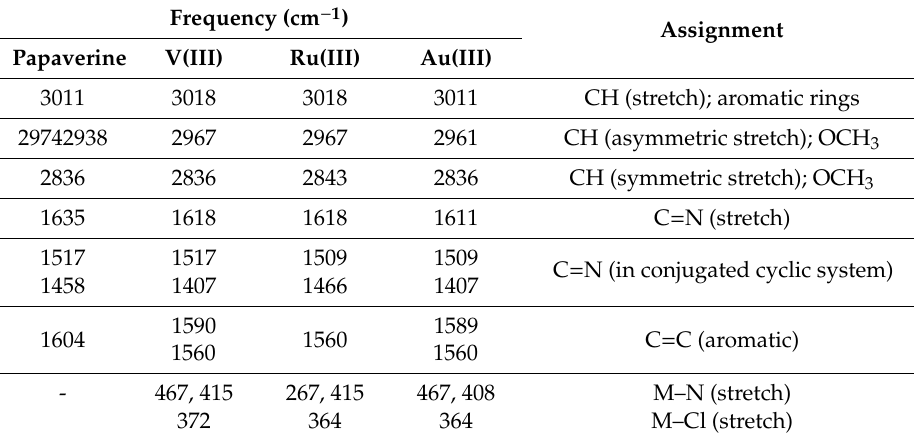
Table 2. IR characteristics of papaverine hydrochloride and its